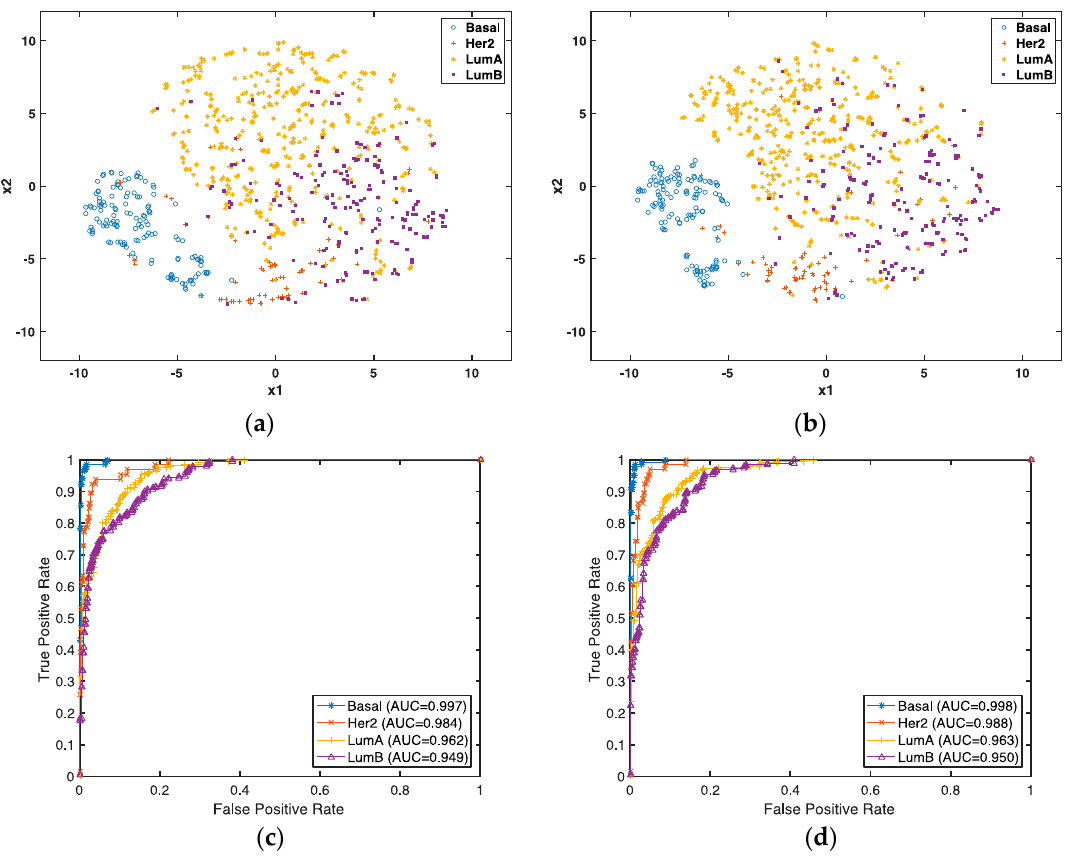
Figure 2. Visualization of breast cancer subtypes using selected 29 non-coding ( a ) and 36 “all” ( b ) gene features for 839 TCGA RNAseq training set; the sensitivity and specificity of prediction accuracy based on ROC curve for 29 non-coding ( c ) and 36 “all” ( d ) gene features.